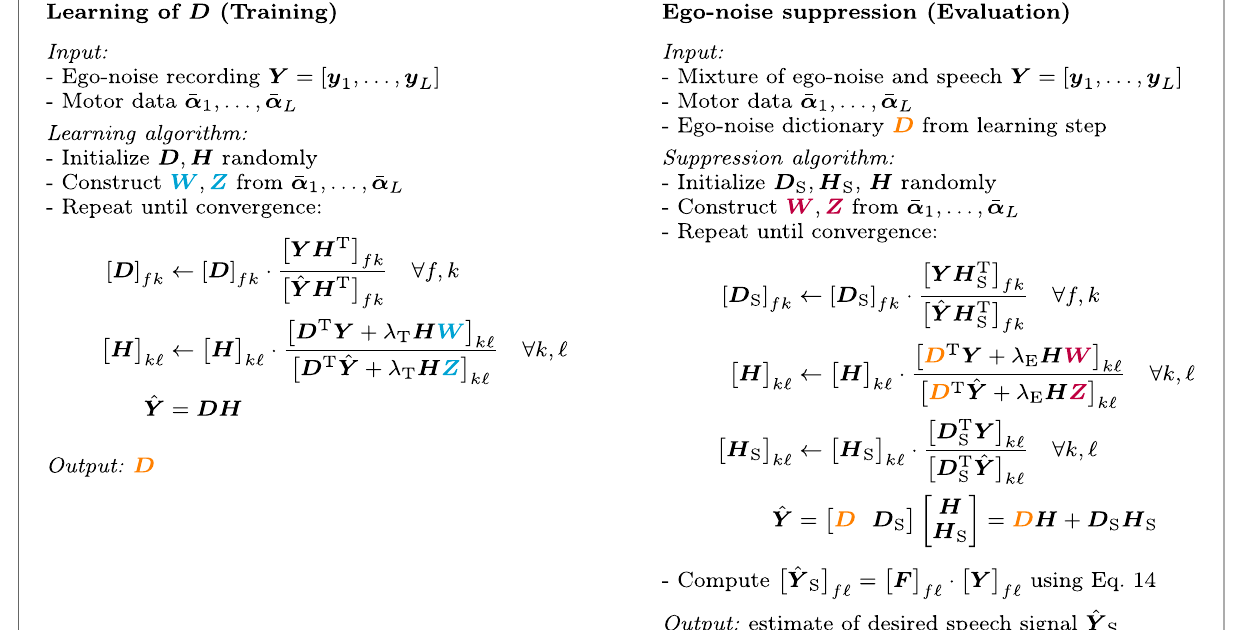
Fig. 4 Overview of the proposed semi-supervised, two-stage algorithm for ego-noise suppression: Learning of D (left) and ego-noise suppression